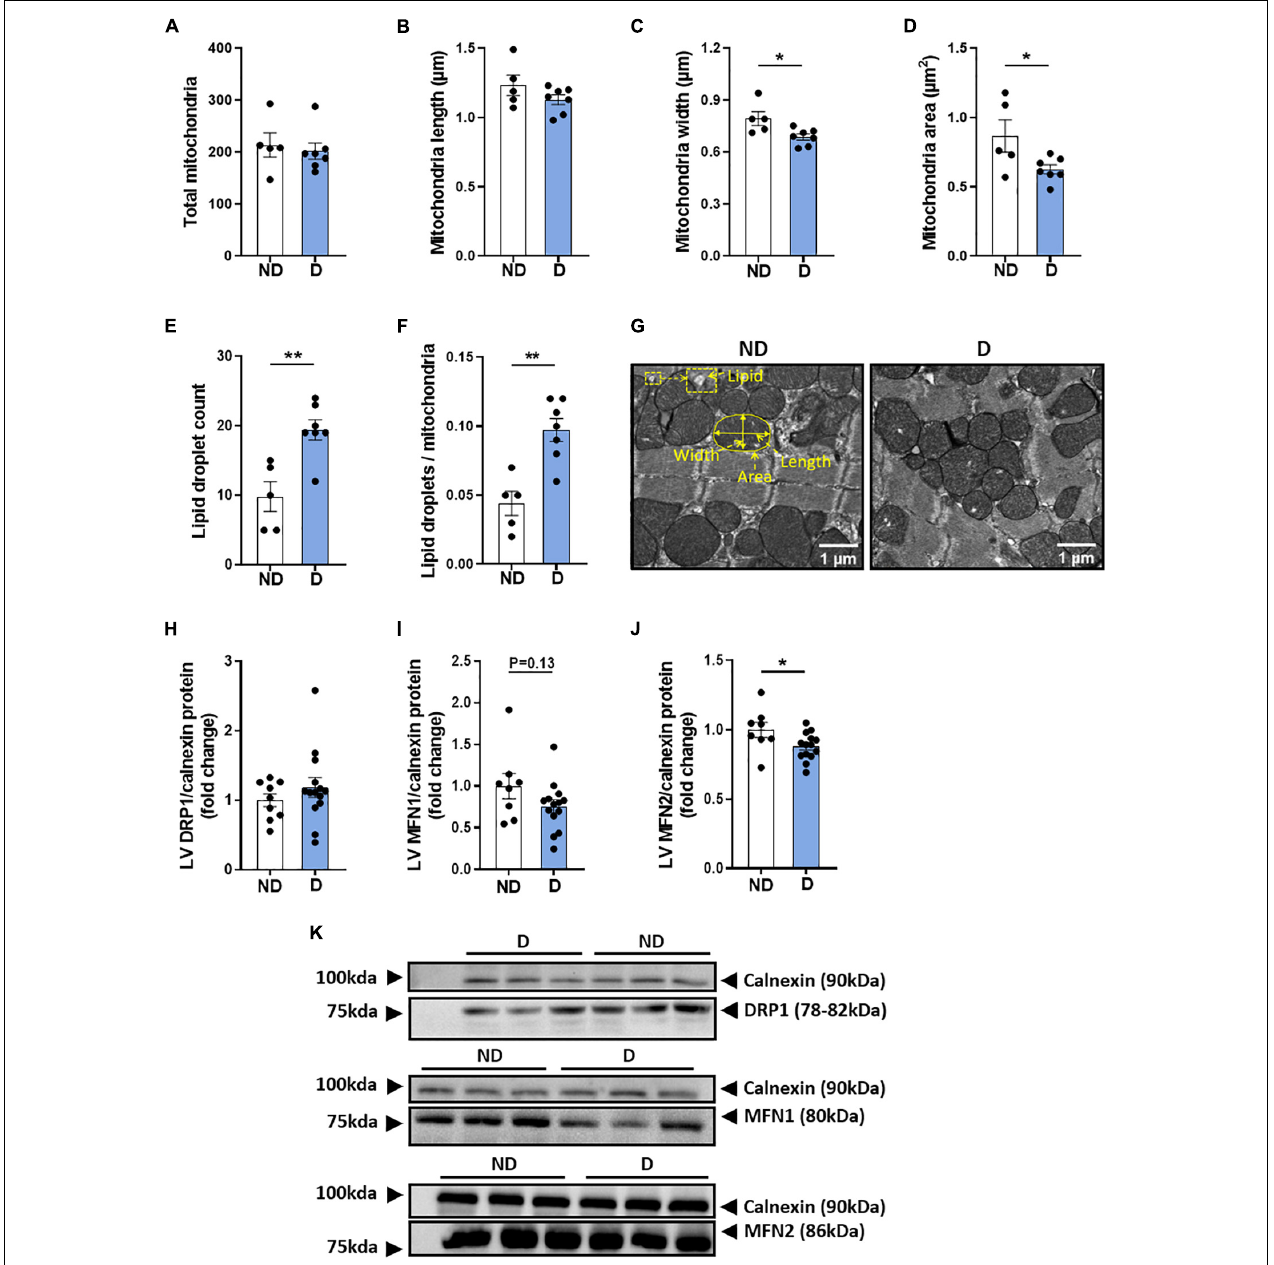
FIGURE 6 | LV mitochondria morphology in diabetic mice. Electron microscopy quantification of (A) total number of mitochondria, (B) mitochondria length, (C) mitochondria width, (D) mitochondria area, (E) total lipid droplet count, (F) lipid droplets/mitochondria ratio, (G) representative electron microscopy images of mitochondria structure (an enlarged image is available to view in Supplementary Figure 2 ). Regulators of mitochondrial morphology: (H) dynamin-related protein 1 (DRP1) and (I) Mitofusin 1 (MFN1), (J) Mitofusin 2 (MFN2), with (K) representative western blot images; Calnexin housekeeper are carried out separately for each protein of interest. Data represented as mean ± SEM. n = 5–14 per group (note individual data points). Data analysis used unpaired t -test. * P < 0.05, ** P < 0.01. ND, non-diabetic; D, diabetes; LV, left